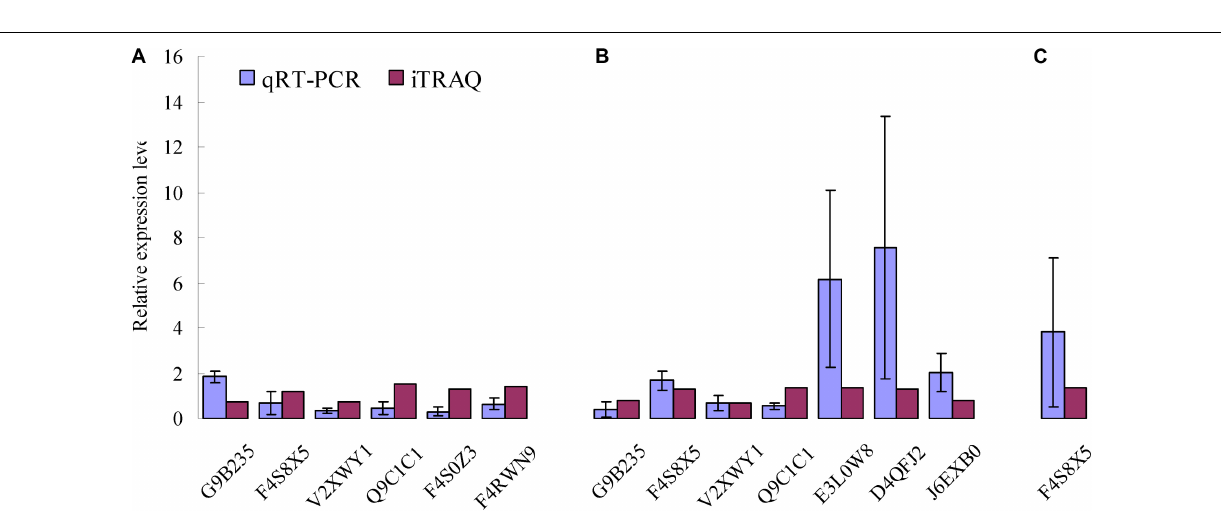
Frontiers in Microbiology |